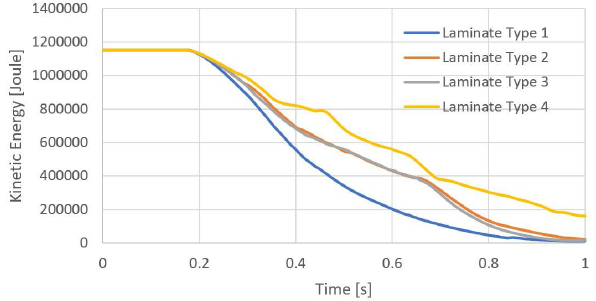
Figure 36: Force – displacement of each type of laminate based on the impact at a speed of 5 knots Figure 37: Kinetic Energy – Time of each type of laminate based on impact at a speed of 5 knots